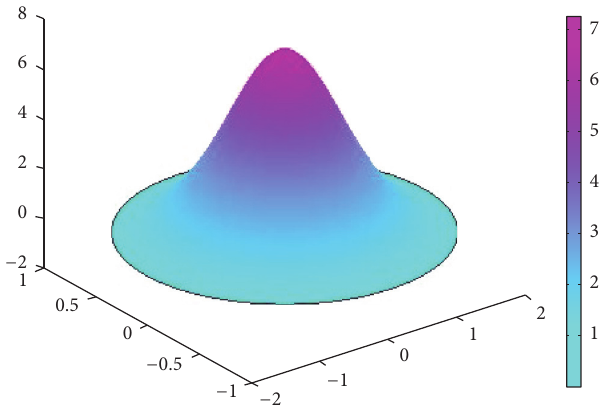
(𝑥,𝑦)+𝛾 2 (𝑥,𝑦)] 1/2 Figure 6: Stress function Ψ 3 ; 𝑎 = 2 , 𝑏 = 1 ; 𝑘 1 = 𝑘 3 = 1 , 𝑘 2 = 𝑐 = 2 . 𝑥𝑧 𝑦𝑧 Color spectrum: Ψ 3